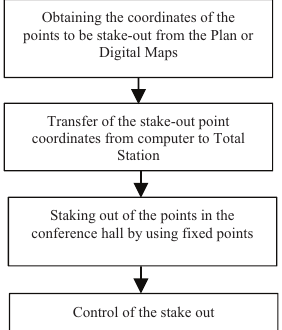
Figure 2. The flowchart of the stake-out of the seats